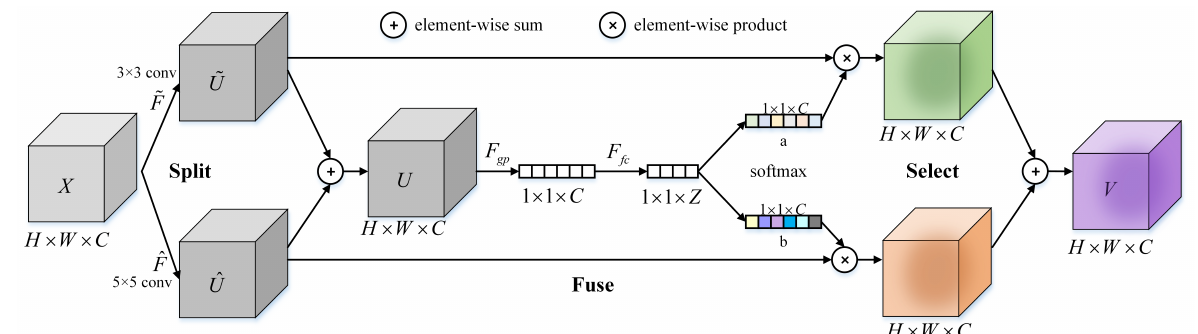
Figure 27. Selective Kernel convolution block.